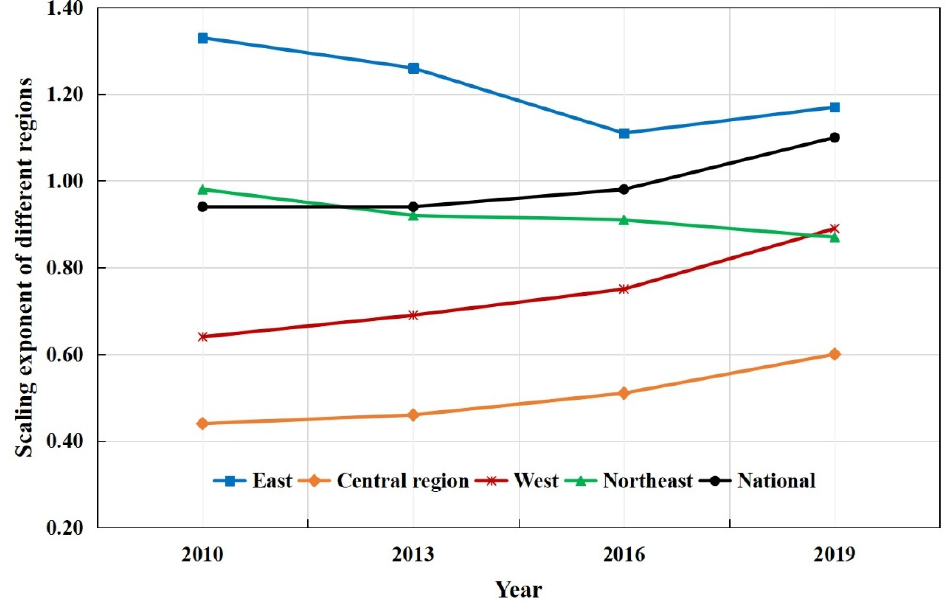
Figure 2. Scaling exponents of industrial land of different regions in China, 2010–2019.